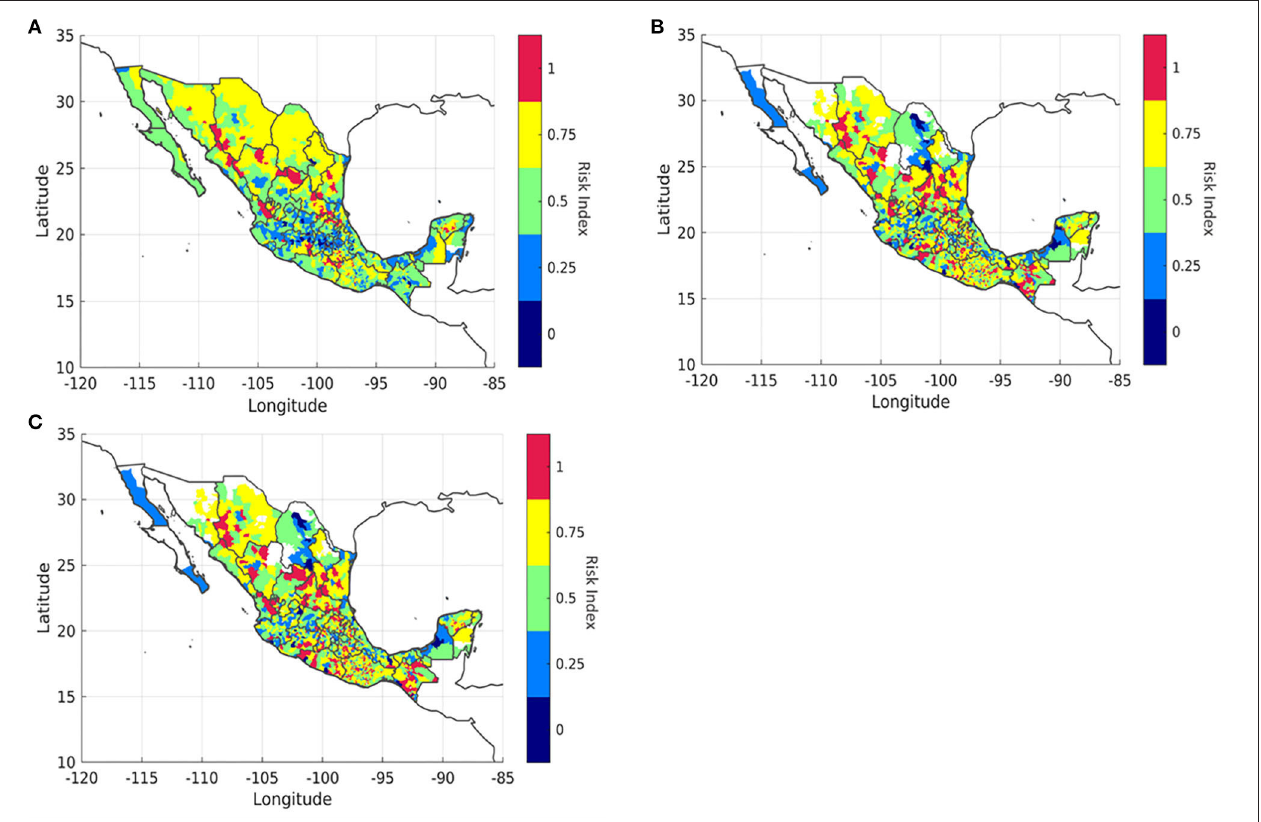
FIGURE 3 | (A) Historical Risk Index, (B) Future Risk Index 2070 and the RCP8.5 scenario, (C) Future Risk Index 2070 and the RCP8.5 + 25% scenario.